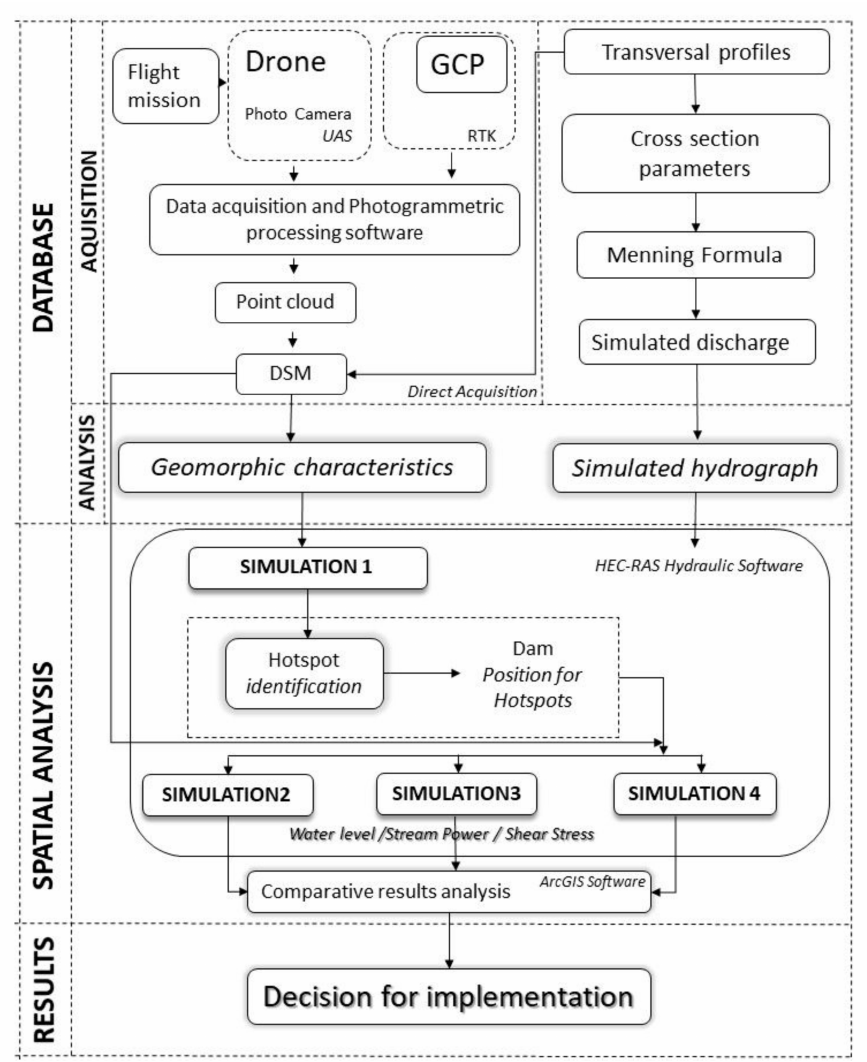
Figure 2. Methodological